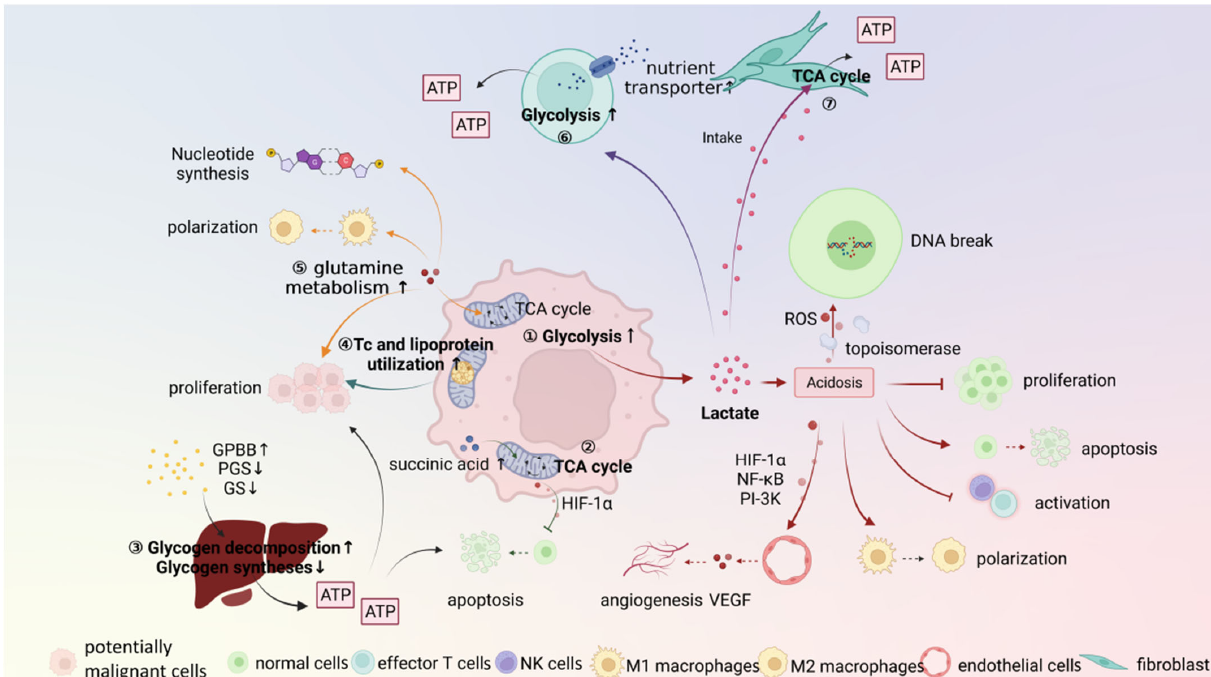
Figure 2. Characteristics of the metabolic microenvironment and metabolic reprogramming in carcinogenesis of OPMDs. ① The acidosis causes a series of adverse events due to increased glycolysis. ② TCA cycle also exists in potentially malignant cells and promotes cell apoptosis. ③ – ⑤ Metabolism of other substances, including glycogen, lipid, and protein metabolism, also participate in OPMDs carcinogenesis by providing energy and metabolic substrates. ⑥ , ⑦ The metabolic reprogramming of fibroblasts and T cells is in response to the microenvironmental changes and an attempt to reverse the unfavorable conditions. Pointed arrows mean “promote” and blunt ‐ end arrows mean “inhibit”. The upward arrows “ ↑ ” indicate “increase”, and downward arrows “ ↓ ” indicate “decrease”. ROS, reactive oxygen species; TCA cycle, tricarboxylic acid cycle; HIF ‐ 1 α , hypoxia ‐ inducible factor ‐ 1 α ; NF ‐κ B, nuclear factor ‐κ B; PI ‐ 3K, phosphatidylinositol ‐ 3